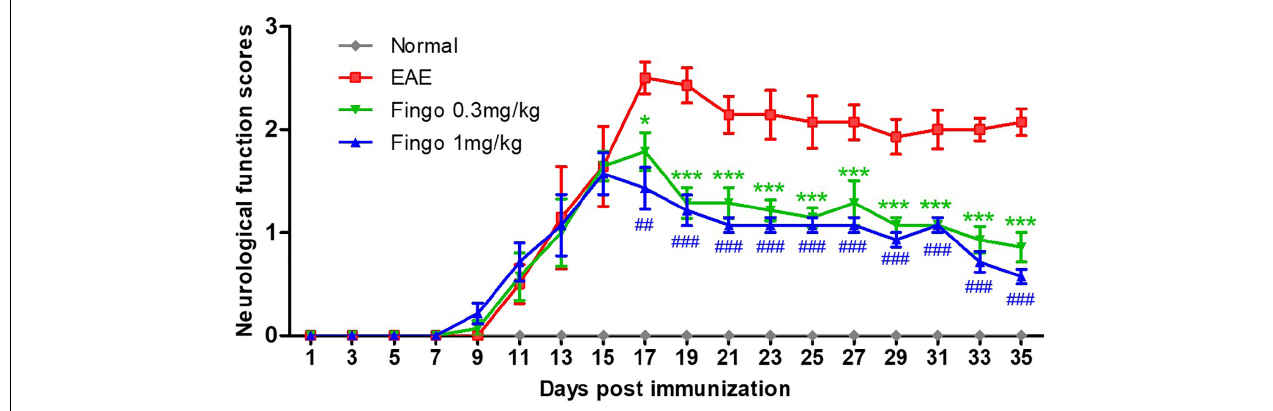
FIGURE 1 | Clinical function scores of EAE mice. Scores are presented as mean ± SD. The treated group was given fingolimod at the dose of 0.3 and 1 mg/kg, respectively, from day 12 when 50% of immunized animals had developed clinical signs of EAE. Values represent mean ± SD. One-way ANOVA plus Turkey’s multiple comparisons. Compared to the control group: * P < 0.05, *** P < 0.001, ## P < 0.01, ### P <